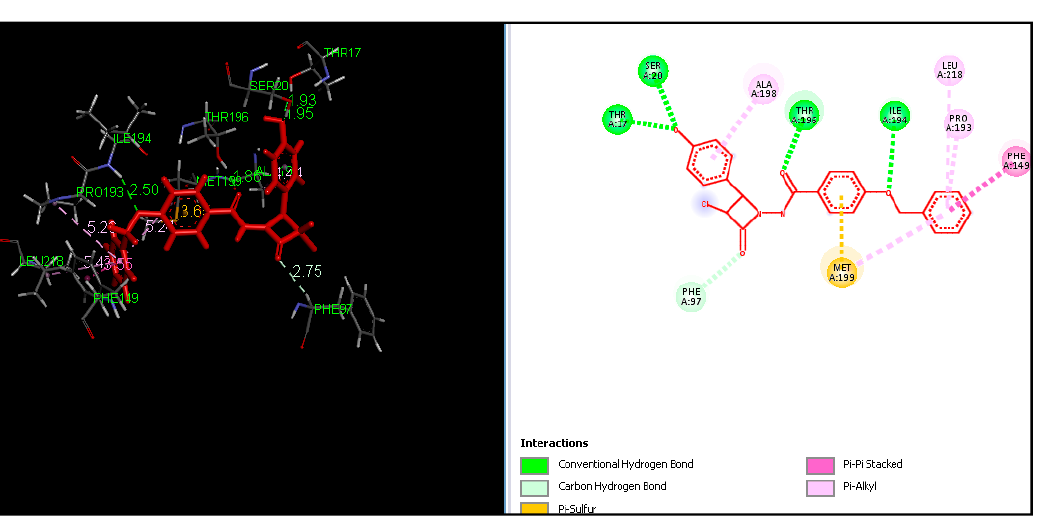
Figure 3. Binding Pose and molecular interactions of 6a into the active site of InhA.